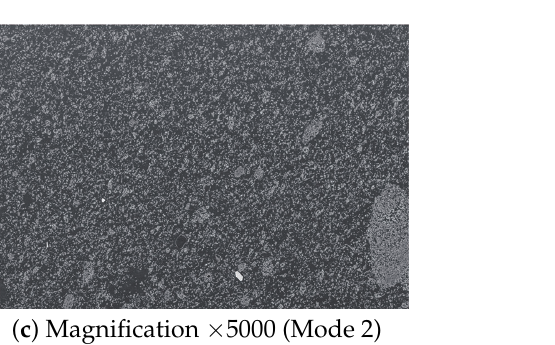
Figure 1. Examples of electron microscope images taken under different conditions: images in ( a , b ) were taken with the same imaging condition and images in ( c , d ) were also taken with the same imaging